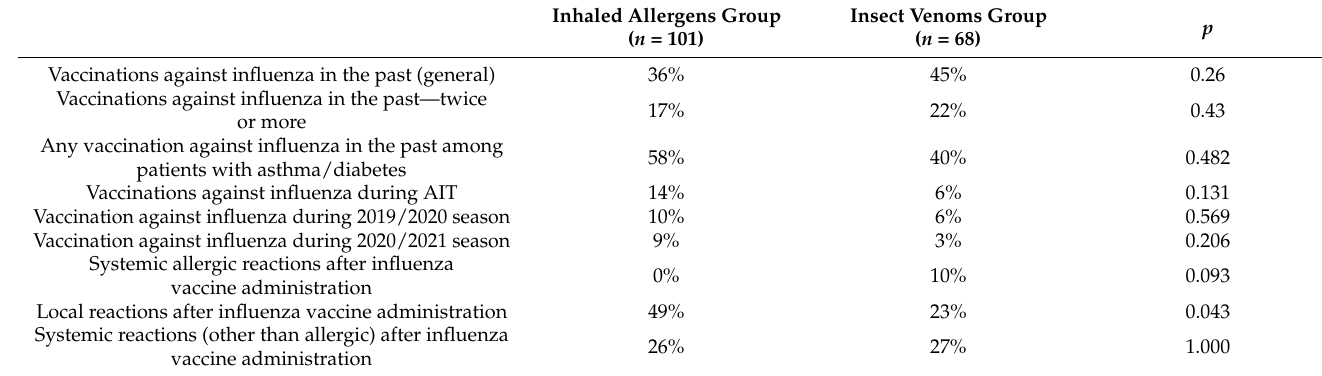
Table 2. Influenza vaccine coverage before and during AIT along with influenza vaccine adverse